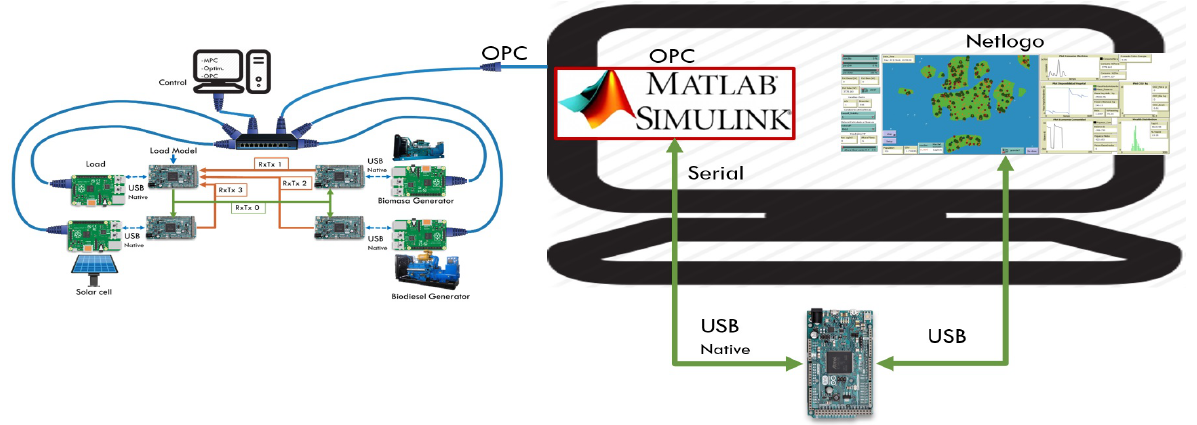
Figure 21. Netlogo–Matlab–Microgrid emulated communication